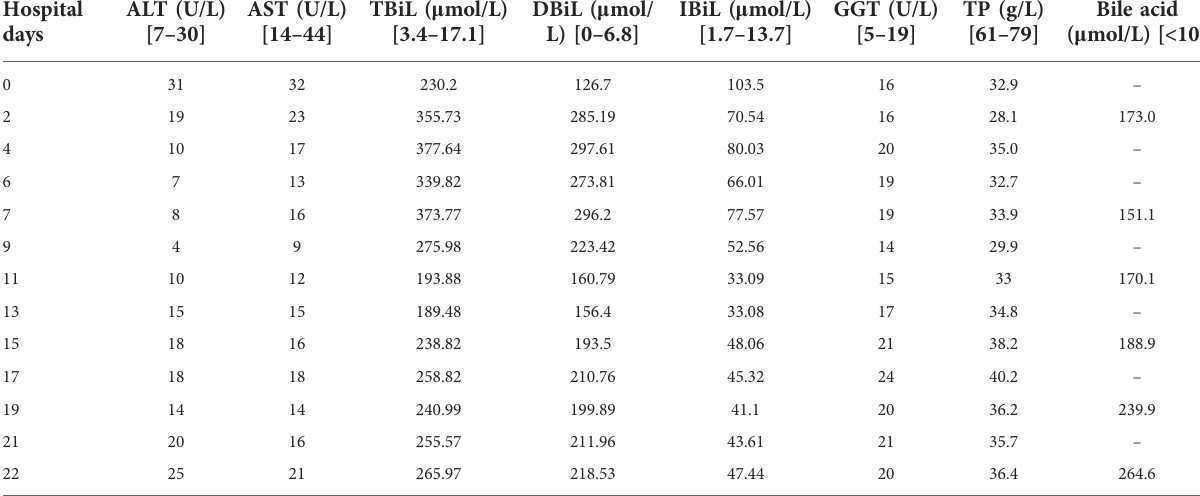
TABLE 1 Changes of transaminase, bile acid, and bilirubin in the